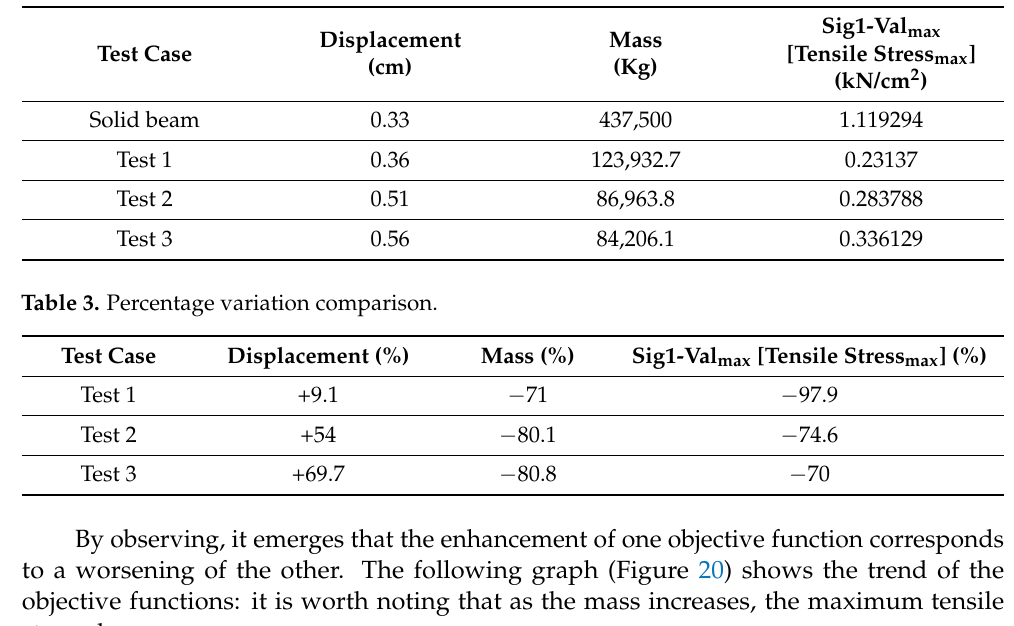
Figure 19. Three different optimization results retrieved in Pareto front. Table 2. Optimization results.